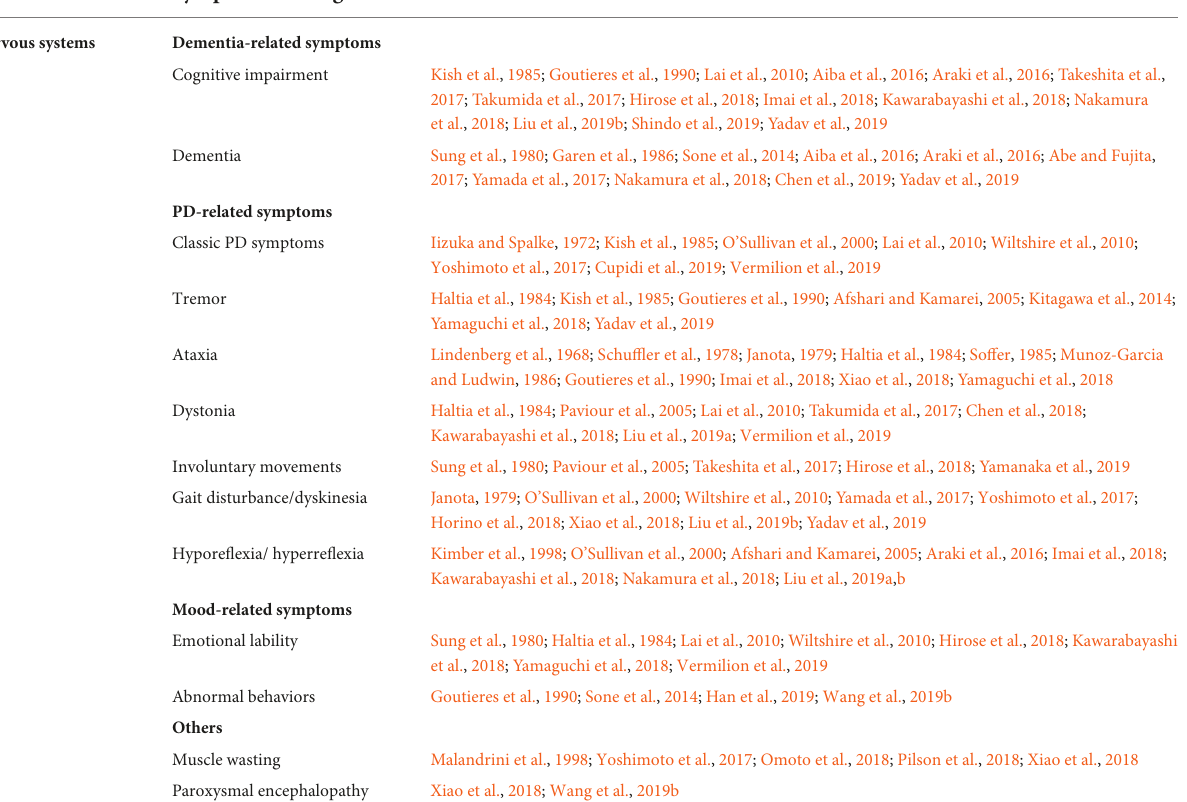
TABLE 1 The clinical symptoms of NIID in different